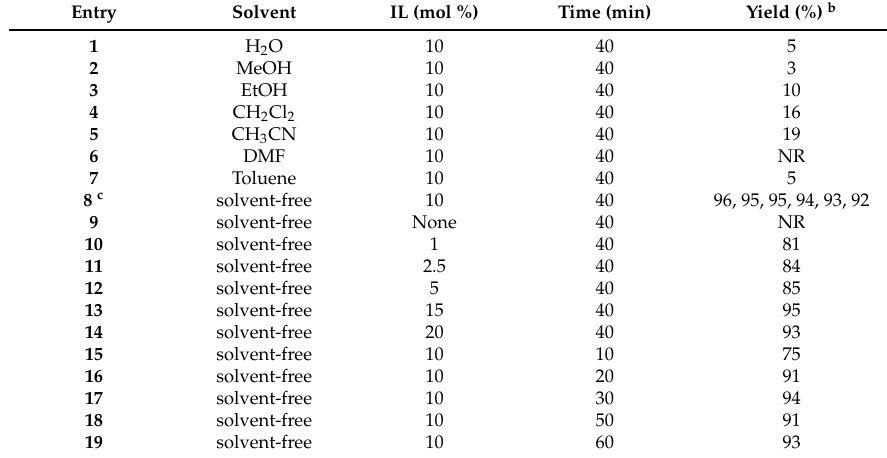
Table 1. Effect of catalyst [C 2 O 2 BBTA][TFA] under different conditions for the reaction of aryl aldehyde, β -ketoester and urea a .